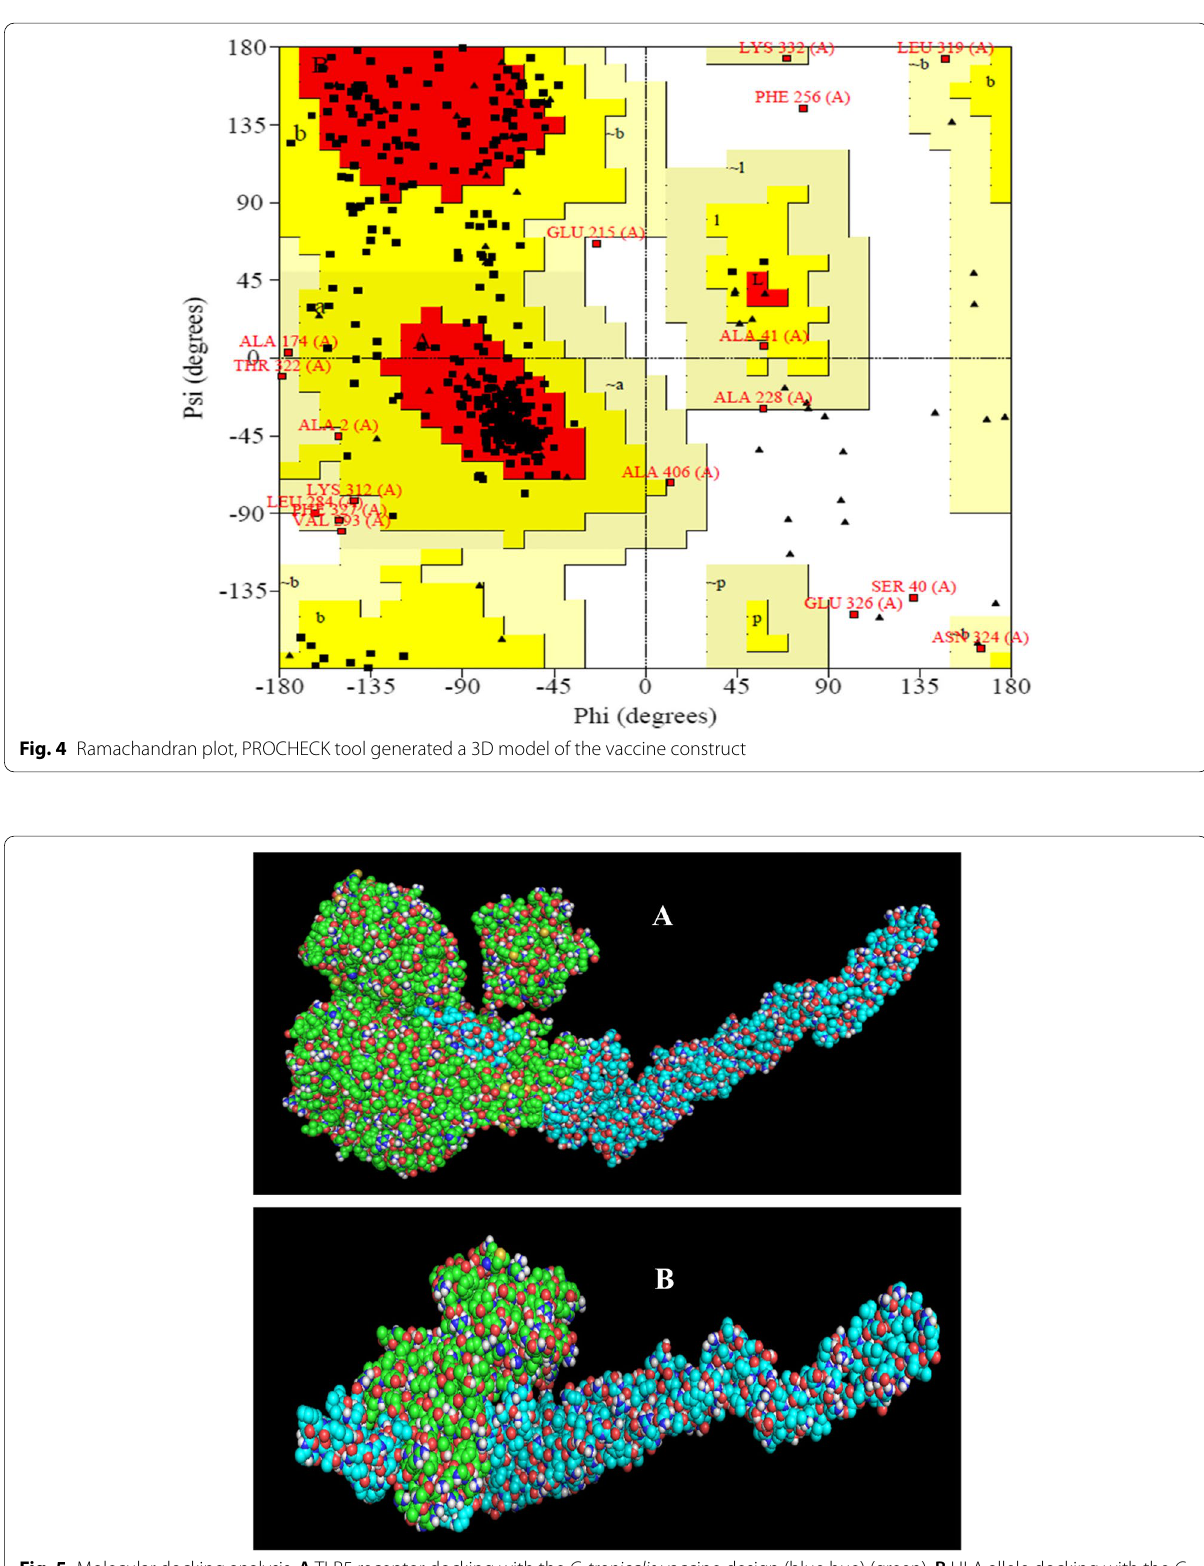
Fig. 5 Molecular docking analysis: A TLR5 receptor docking with the C. tropicalis vaccine design (blue hue) (green). B HLA allele docking with the C. tropicalis vaccine construct (blue) (green in